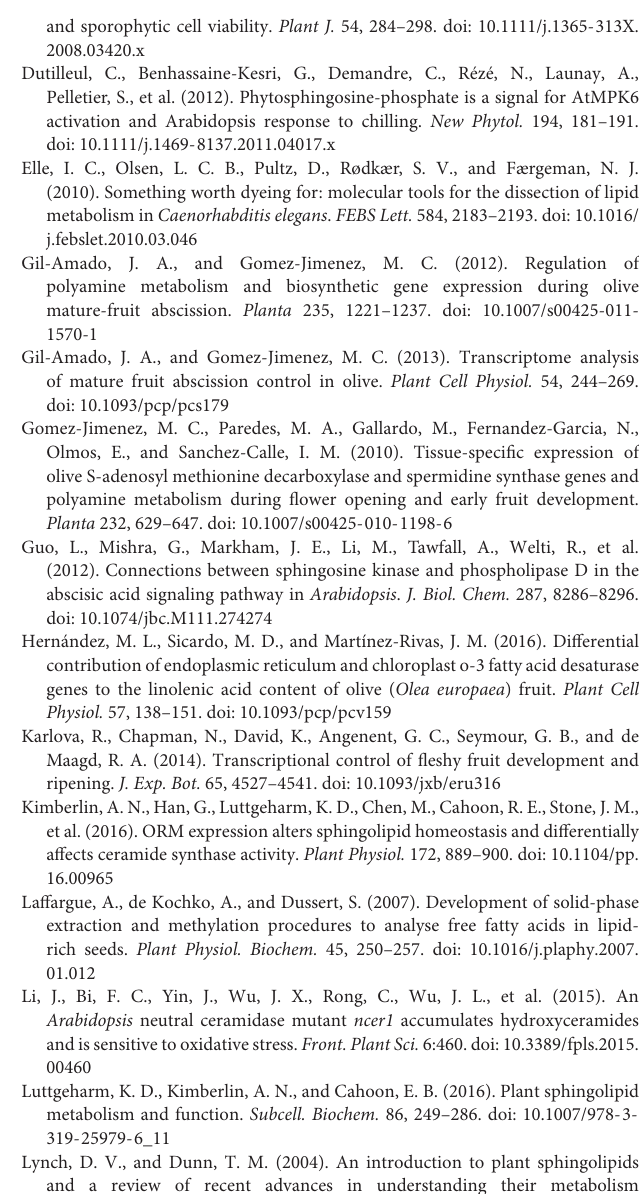
FIGURE S1 | Viability was successfully tested using trypan blue, showing a protoplast after trypan blue treatment; trypan blue is excluded from the cytosol of intact cells (here shown after BD-SM treatment). Scale bars are 5 µ